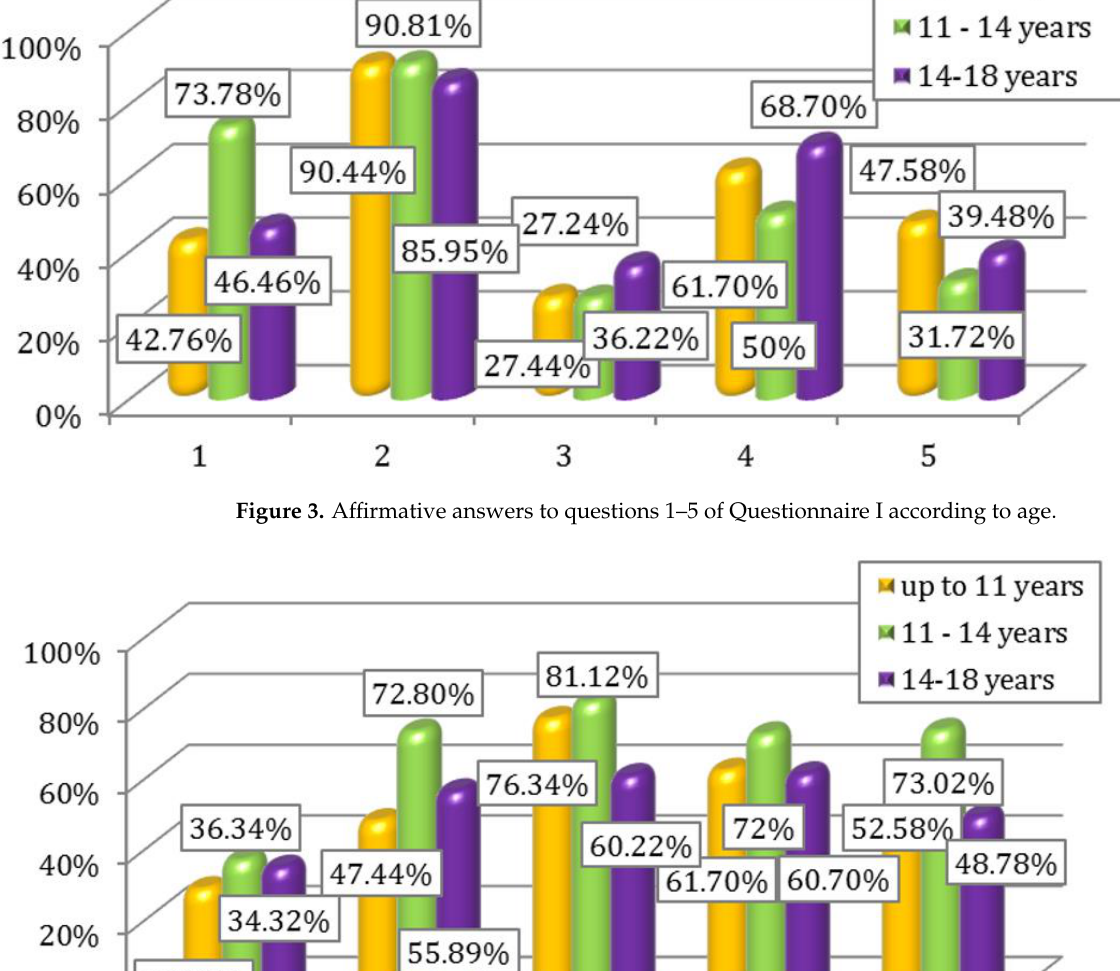
Table 5. The results of Questionnaire II according to the gender of the subjects.